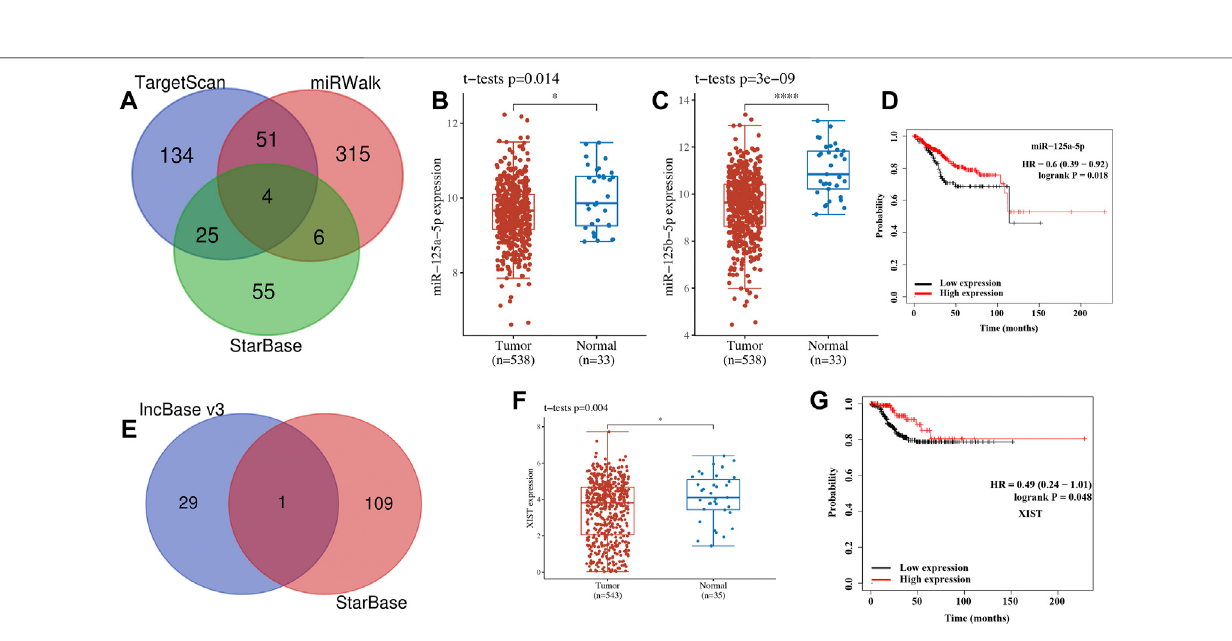
FIGURE10 | lncRNA – miRNA – mRNA regulatory axis inuterine corpusendometrial carcinoma (UCEC). (A) ThemiRNAtargets predicted byTargetScan,miRWalk, andStarBase. (B – D) Theexpressionandprognosissigni fi canceofmiRNAtargetinUCEC. (F) ThelncRNAtargetspredictedbylncBaseandStarBase. (F,G) Expression and prognosis signi fi cance of lncRNA XIST in